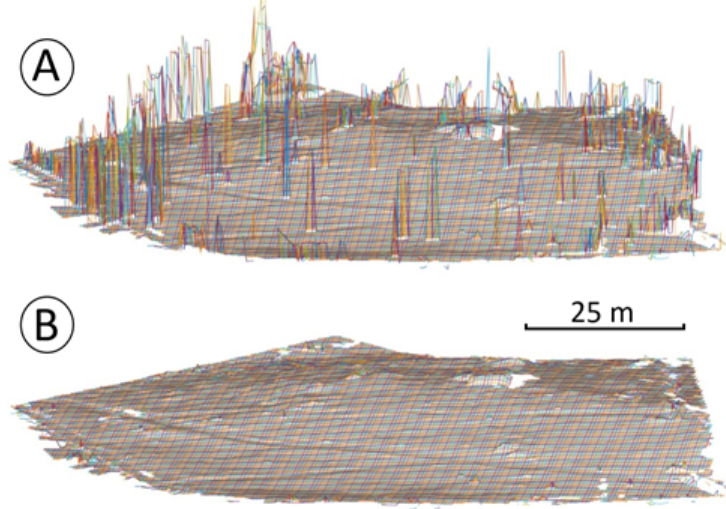
Figure 9. Terrain modeling showing downward and upward